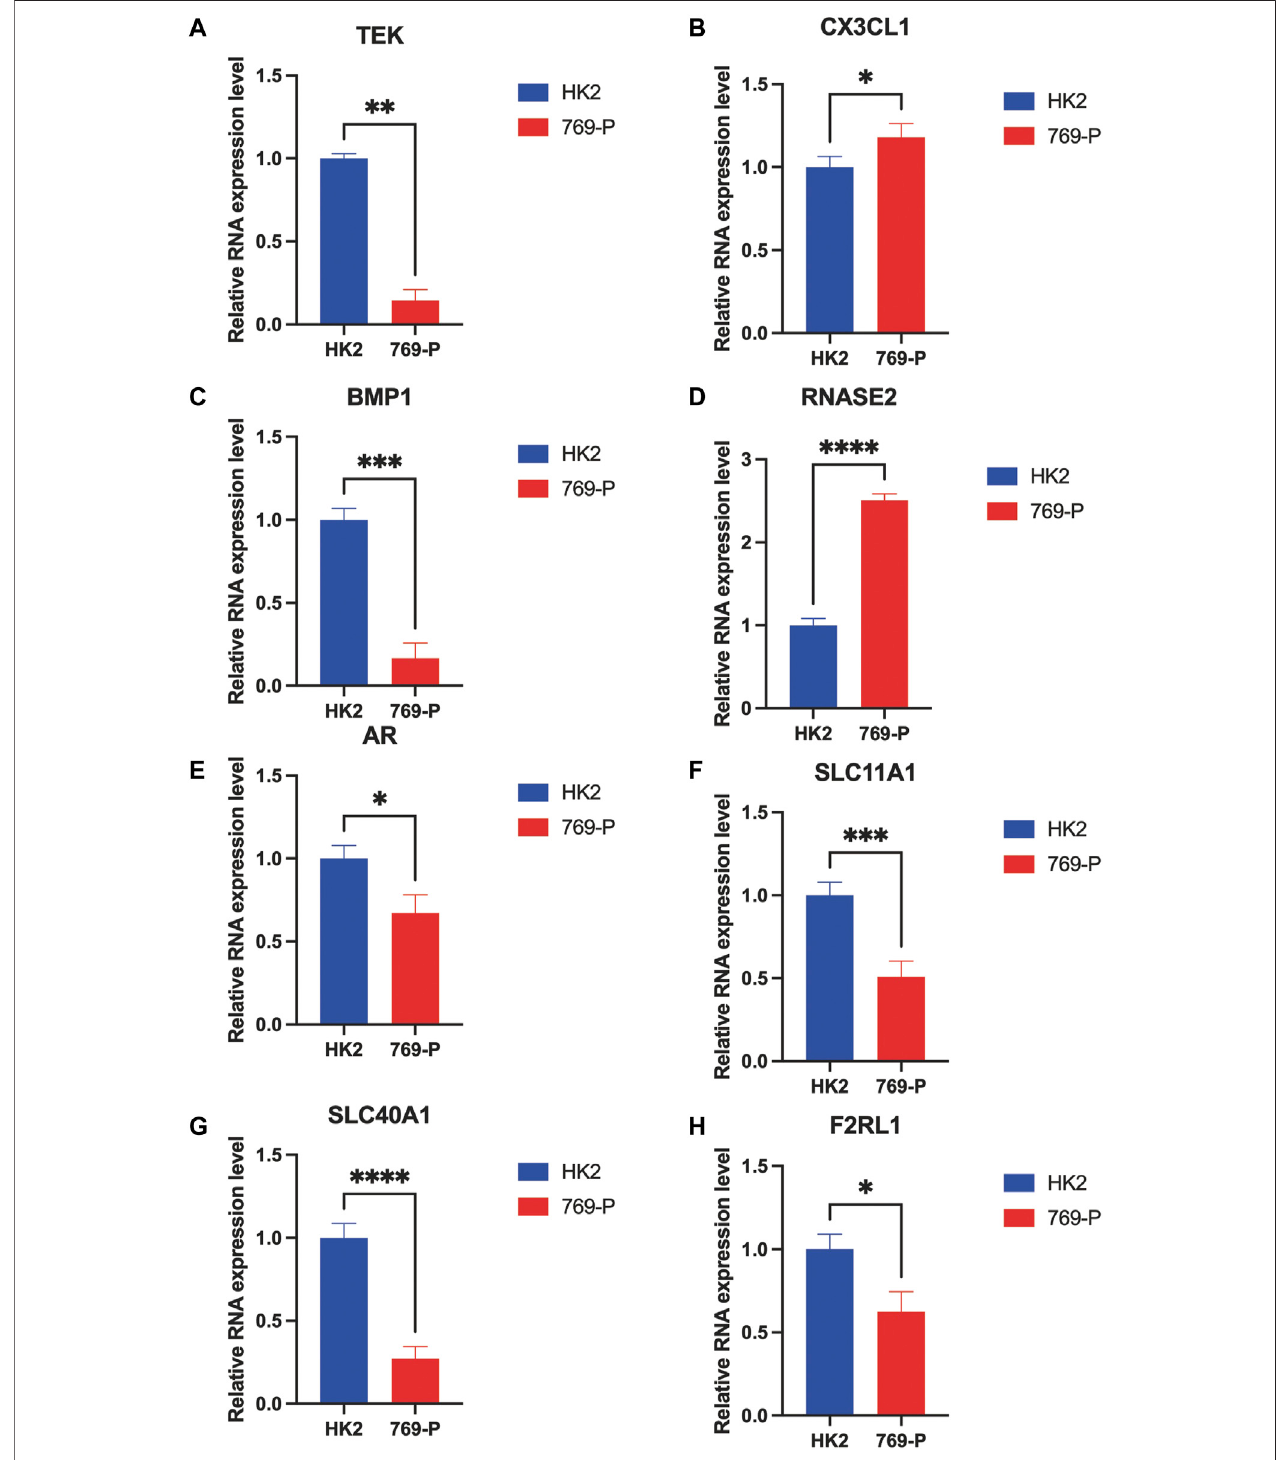
FIGURE7| RT-qPCRcon fi rmedthedifferenceoftheprognosticgeneexpressioninnormalrenalandrenalcellcarcinomas.* p < 0.05,** p < 0.01,*** p < 0.001,and **** p < 0.0001.